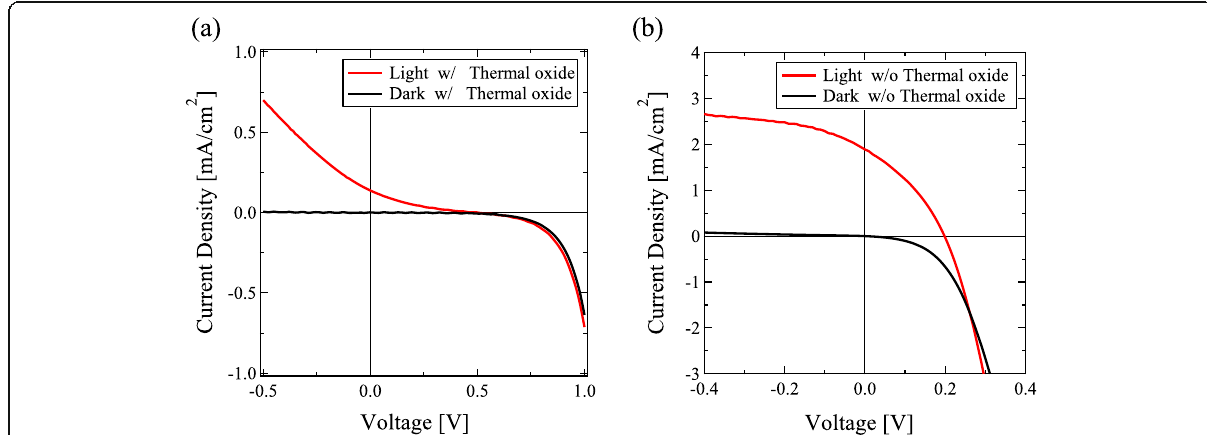
Fig. 5 J - V characteristics of the solar cell structure a with thermal oxide and b without thermal oxide. 10-nm-thick TiO x :Nb was deposited in this solar cell